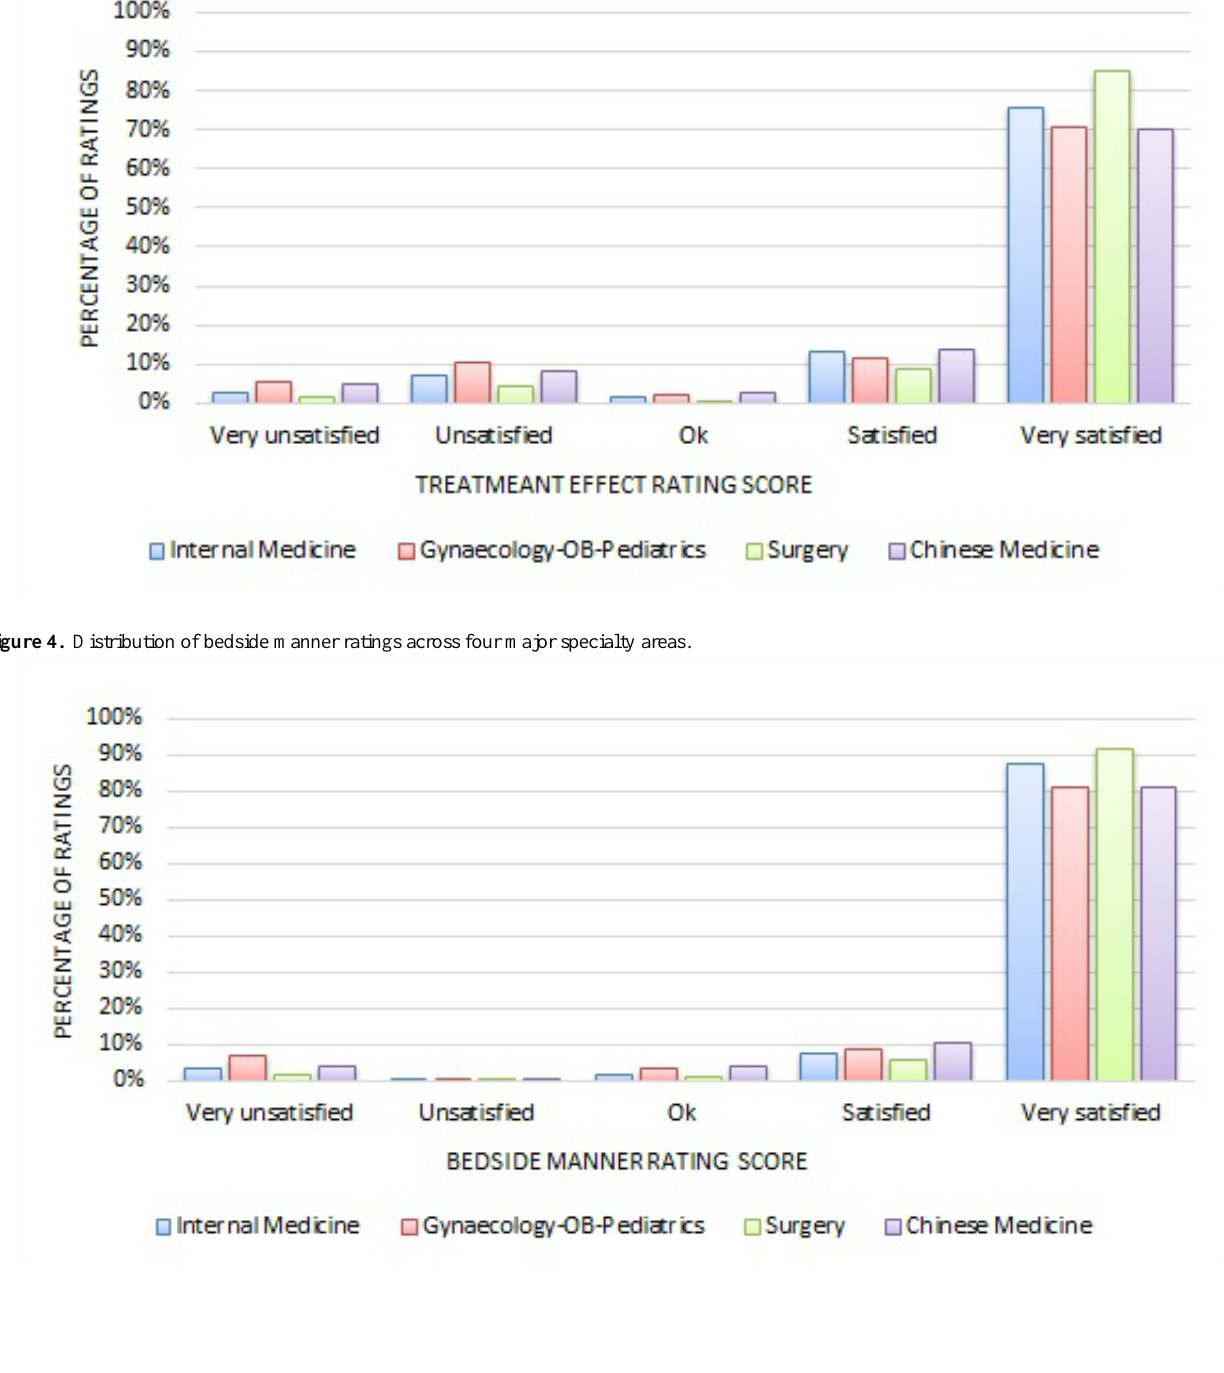
Figure 3. Distribution of treatment effect ratings across four major specialty areas.